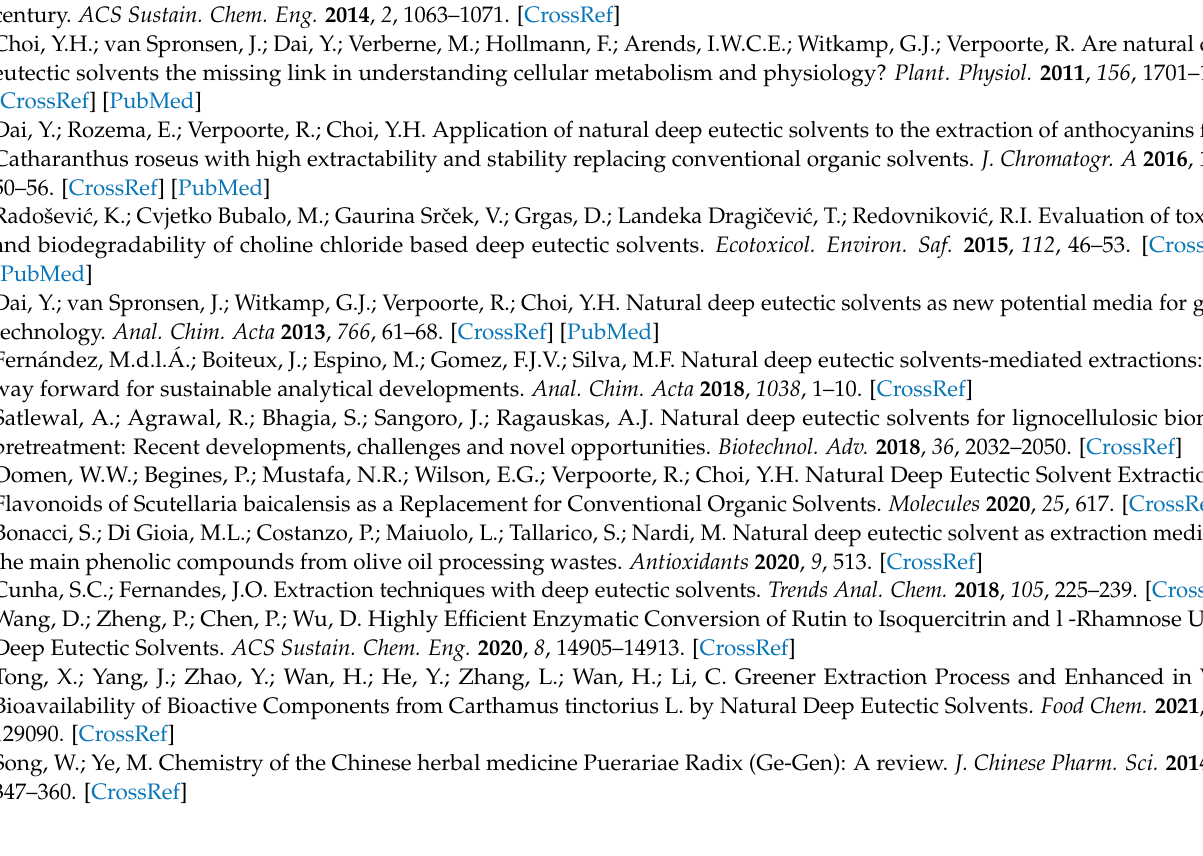
HPLC; Figure S1. HPLC chromatogram of aqueous extract of RP; Figure S2: HPLC chromatogram of L-Pro-Maa extract of RP; Figure S3: HPLC chromatogram of methanol extract of